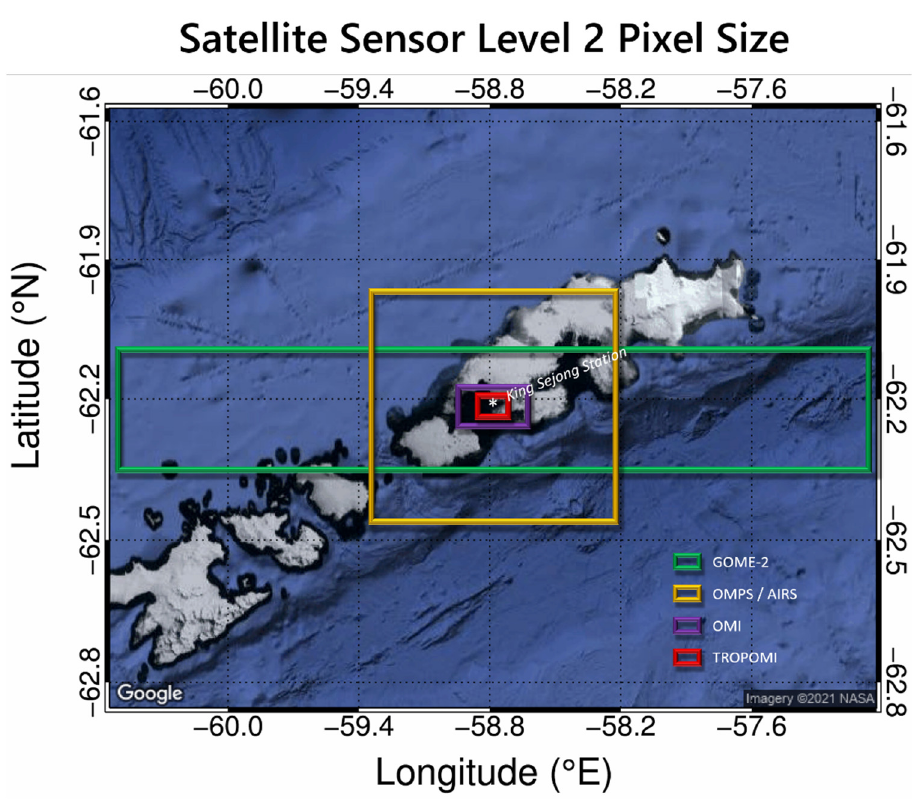
Figure 2. Comparison for the Level 2 pixel sizes of five satellites over the King Sejong station: GOME-2 (green); OMPS and AIRS (yellow) which has same Level 2 pixel size; OMI (purple); and TROPOMI (red).